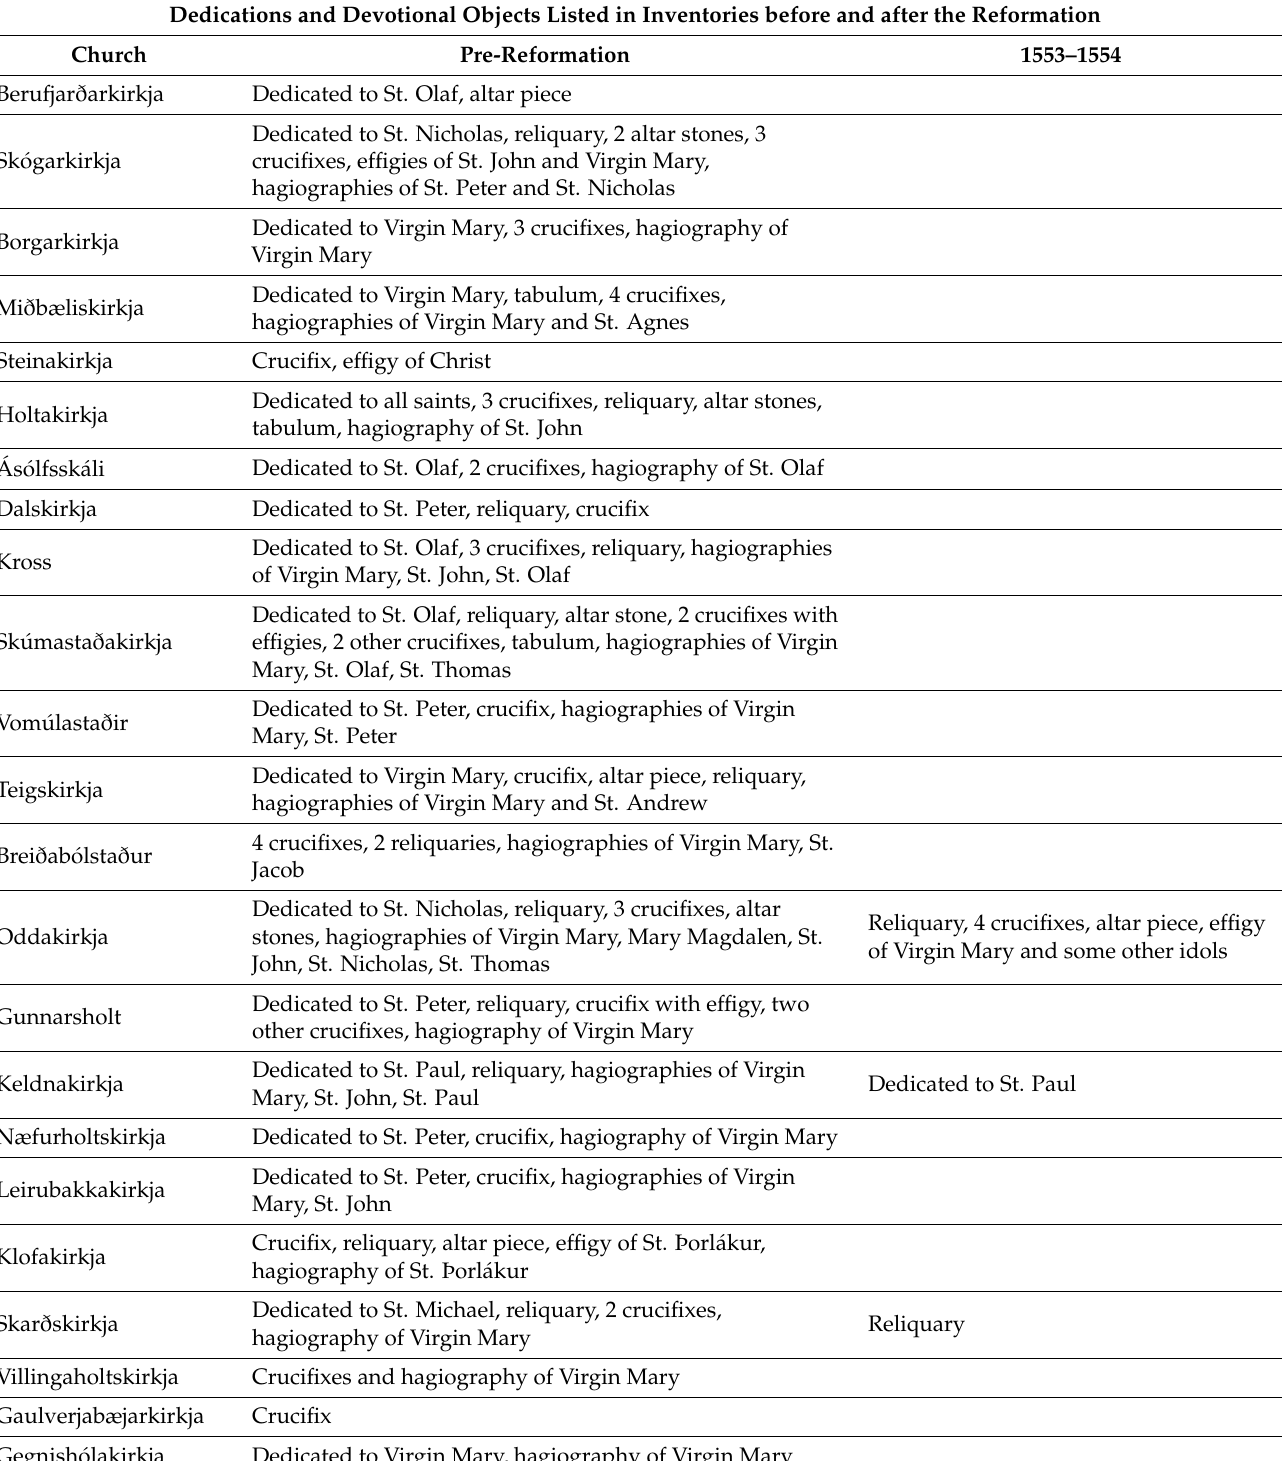
Table 1. A comparison of the inventory book of Bishop Marteinn Einarsson published Diplomatarium Islandicum and the unpublished collection of inventories written by Bjarni Marteinsson in 1601. A majority of the devotional objects listed in the pre-Reformation inventories are missing from later